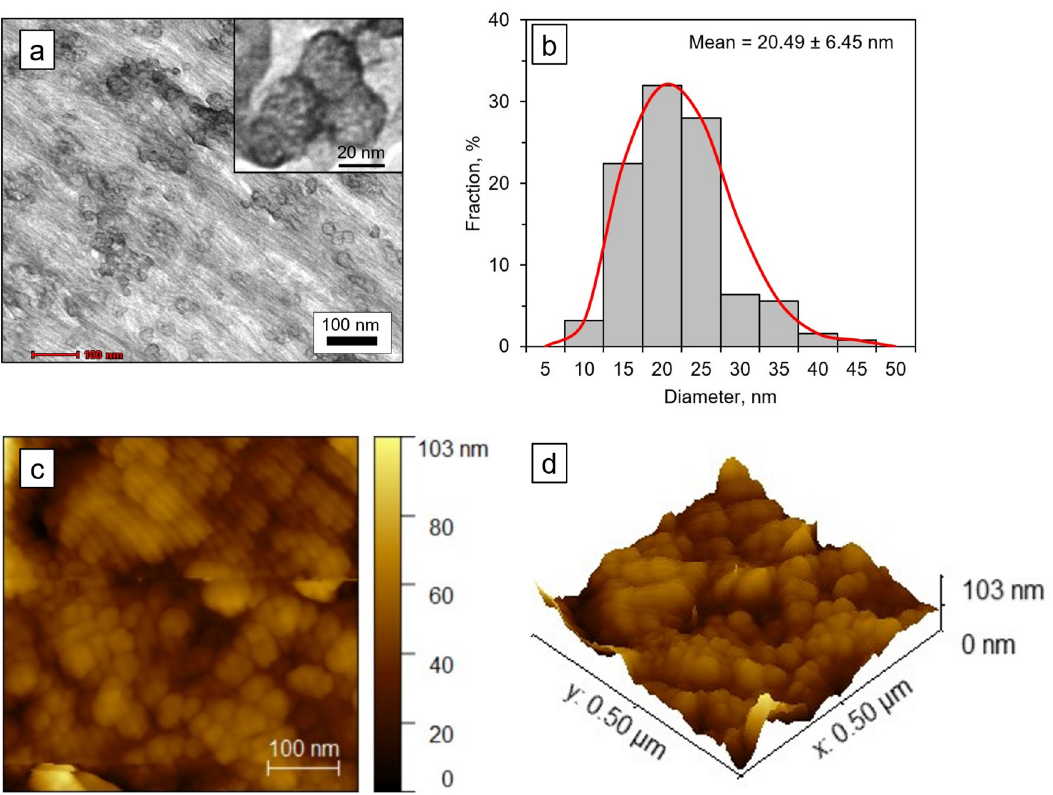
Figure 8. Morphological properties of CNCs obtained after one ‐ pot microwave and oxidative hy ‐ drolysis treatment with 30% H 2 O 2 and 6% H 2 SO 4 : ( a ) TEM image; ( b ) Particle size distribution of nanocellulose analyzed from the TEM images using ImageJ; ( c , d ) AFM images.